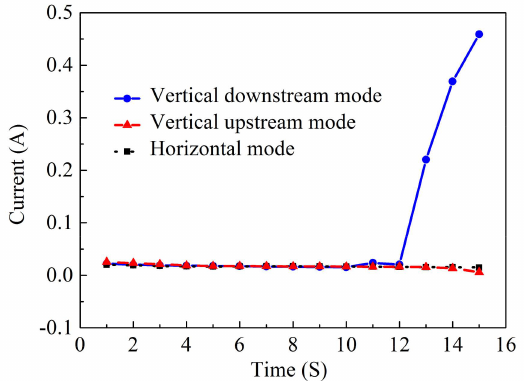
Figure 13. Machining current of the micro-holes machined with di ff erent modes when the electrical voltage was 10 V, the nozzle’s inner diameter was 170 µ m, and the working gap was 100 µ